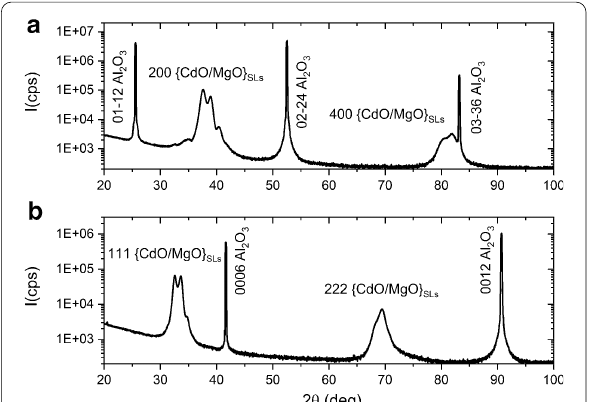
Fig. 1 Theta–2Theta XRD scans of the {CdO(12.5 ML)/MgO(4 ML)} superlattices on a r -Al 2 O 3 and b c -Al 2 O 3